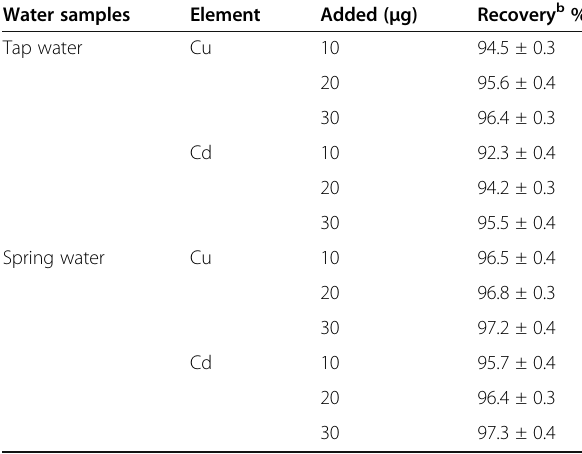
Table 8 Determination of copper and cadmium in water